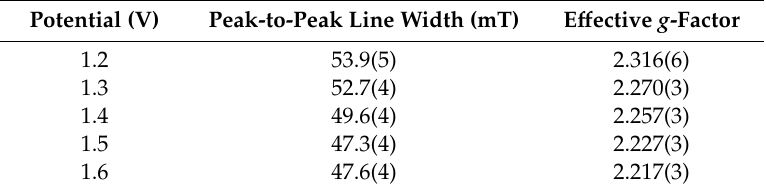
Figure 4. Change in the line shape and spectral position of the Co(IV) species as a function of applied potential. Isolation of the Co(IV) EPR line was achieved by a scaled subtraction of the Co(II) spectral feature of the 1.1 V spectrum from the higher-potential spectra, followed by polynomial background correction. Table 1. Co(IV) line shape parameters vs. applied potential for a Co-Pi film electrodeposited for 22 h at 1.1 V (vs. SHE).